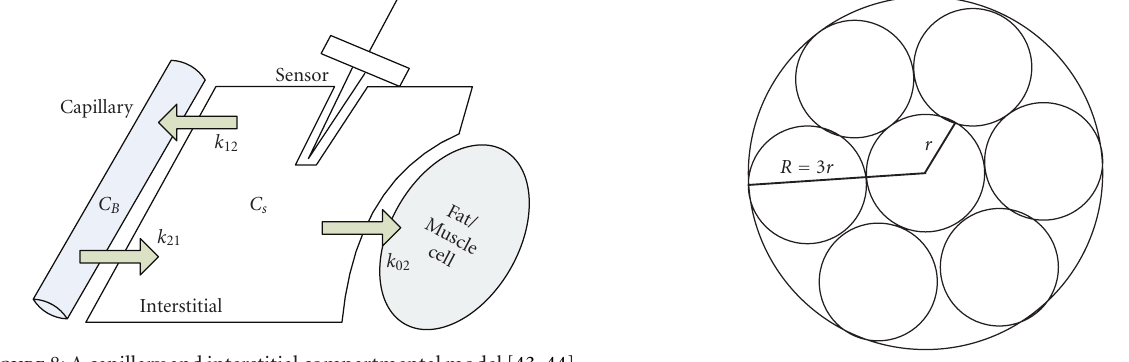
Figure 9: Microneedle honeycomb